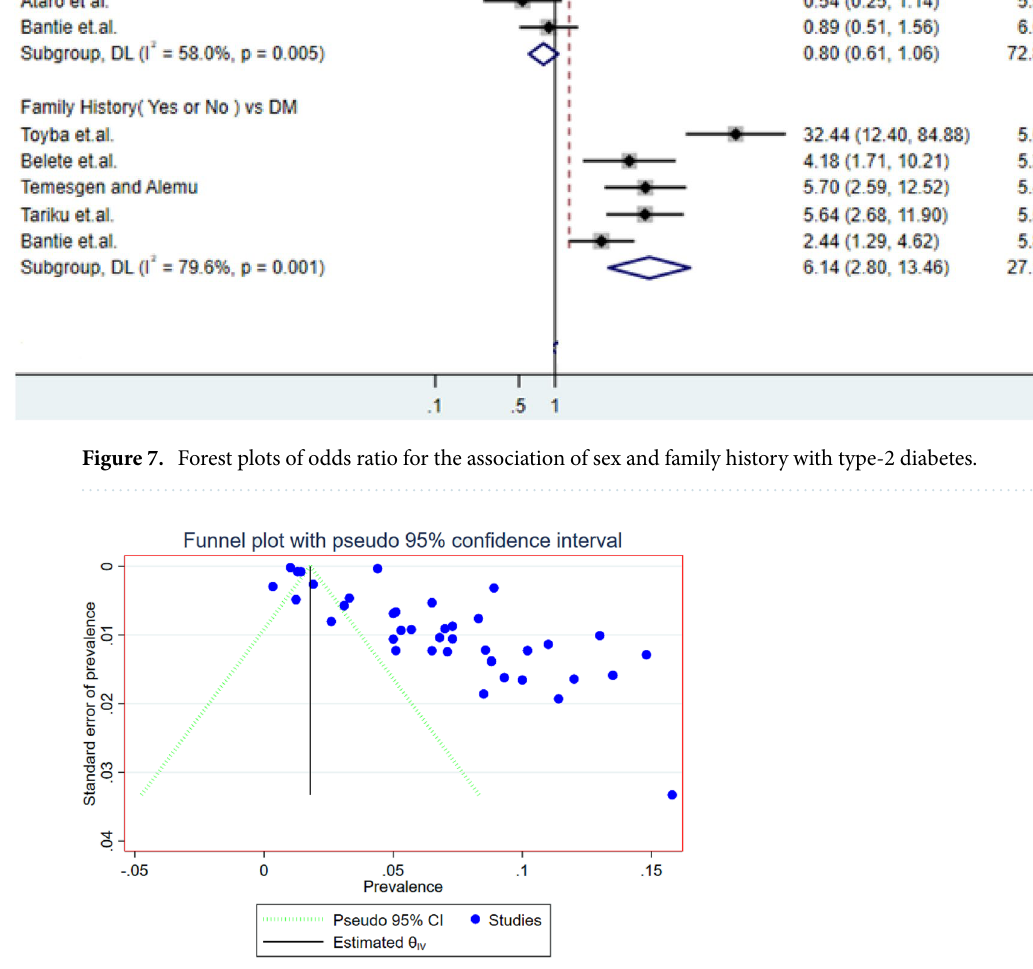
Figure 8. Funnel plot depicts publication bias of included studies on prevalence of DM in